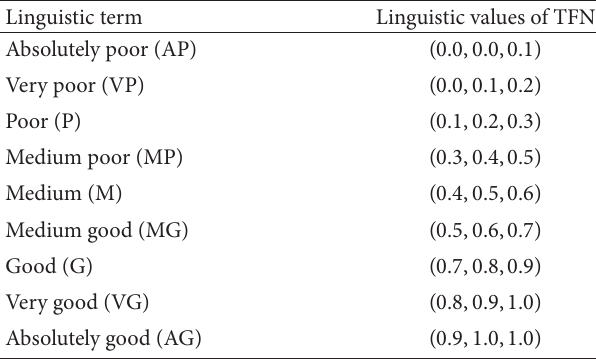
Table 1: Linguistic values of